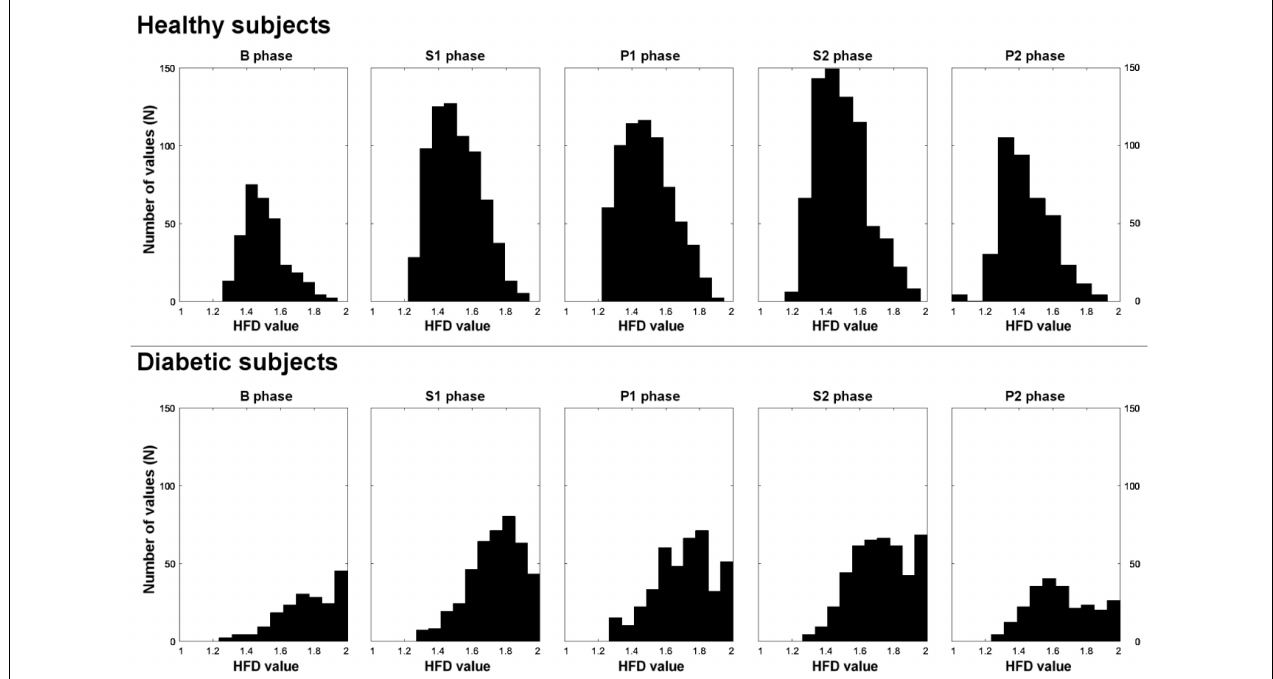
FIGURE 4 | Histograms of aggregated HFD distributions from B, S1, P1, S2, P2 experimental phases, for healthy and diabetic subjects separately.